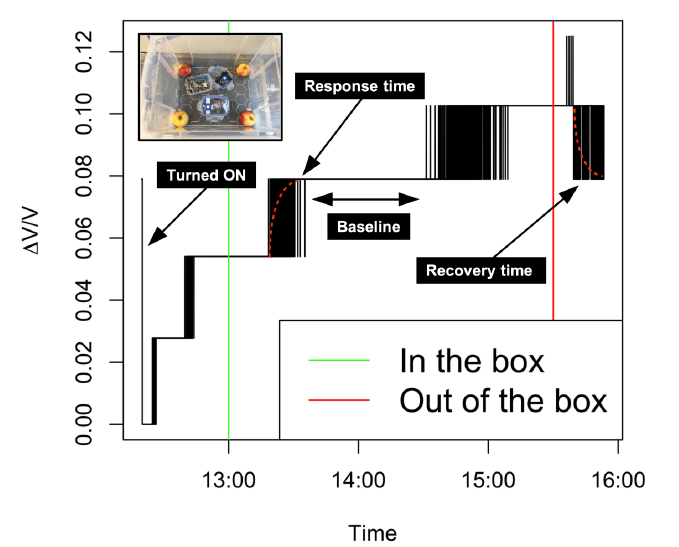
Figure 3. Tests conducted indoors in a sealed environment with an ethylene emission source (apples) that was placed in the box at the green line and removed at the red line.